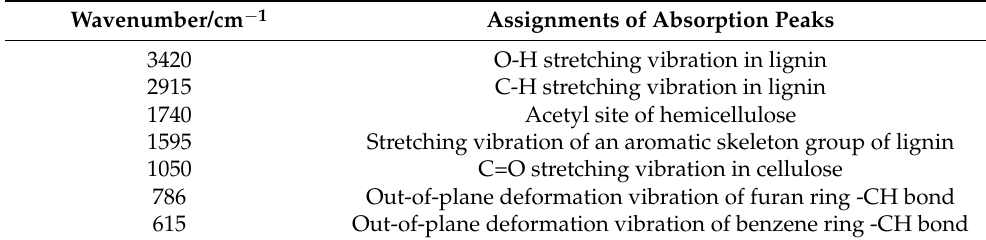
Figure 7. The FTIR of unmodified veneer and FA-modified veneer with different formulations. Table 3. Characteristic absorption peaks and assignments of unmodified veneer and FA-modified veneers with different formulation.